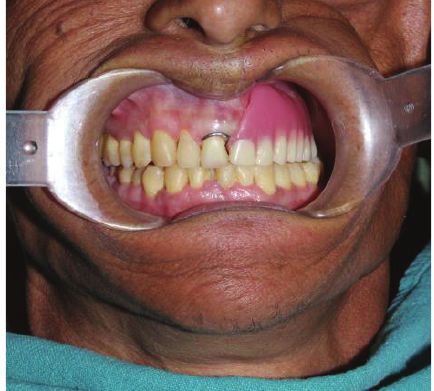
Figure 11: Final prosthesis in situ.